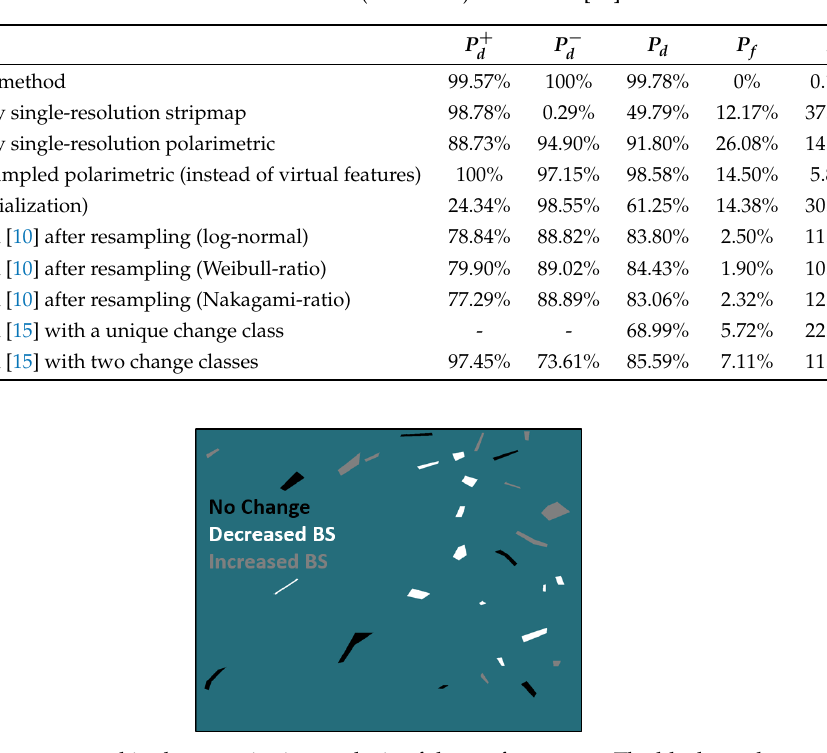
Figure 6. Test map used in the quantitative analysis of the performances. The black patches represent “no-change” areas, while grey and white patches represent “change” areas due to increased and decreased backscattering, respectively. The dark cyan background indicates the pixels that are not included in the test